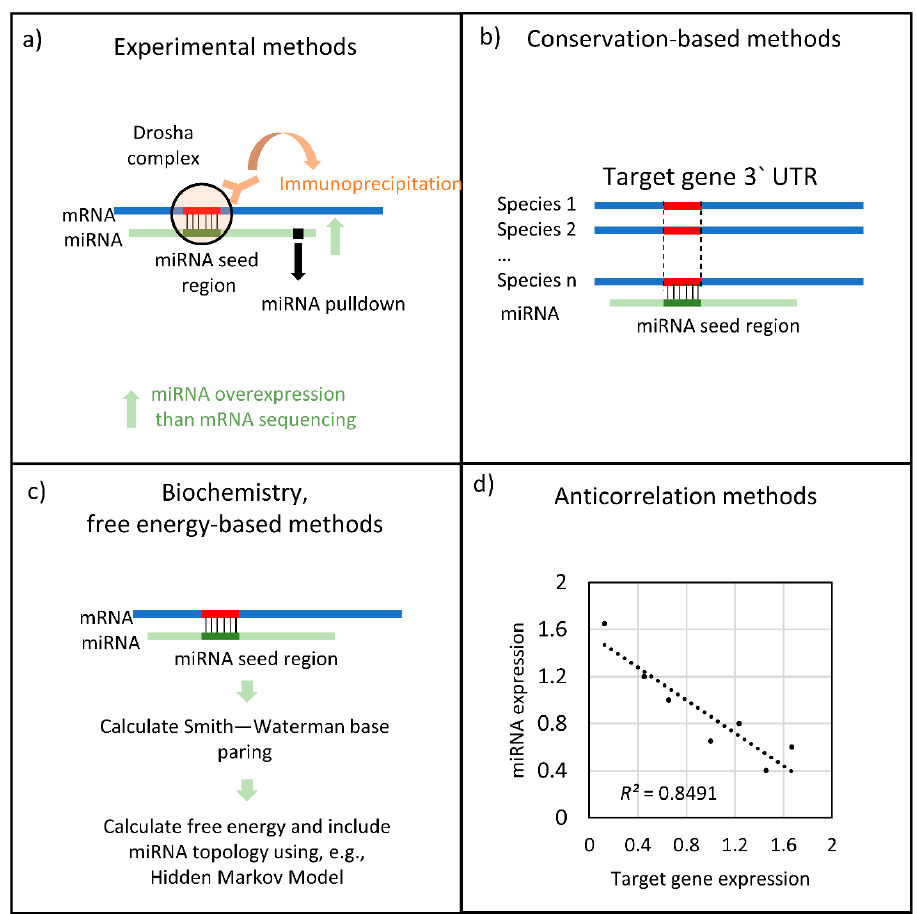
Figure 4. Summary of the various types of miRNA target detection methods.